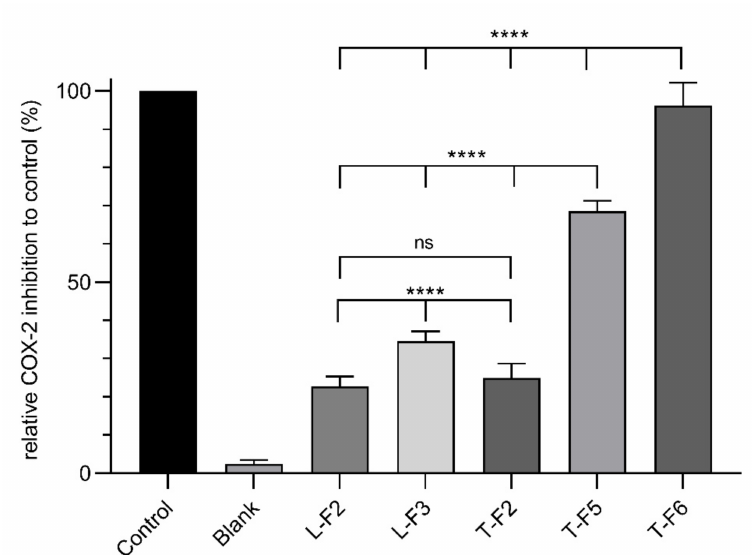
Figure 3. Relative COX-2 inhibition to control (%) of CPC fractions (20 µ g/mL), blank (DMSO) and control set to 100% (0.5 µ M celecoxib). Data points represent the mean value ± standard deviations of six samples. Statistically different expressions were calculated using one-way ANOVA. (****): p < 0.0001; (ns): not